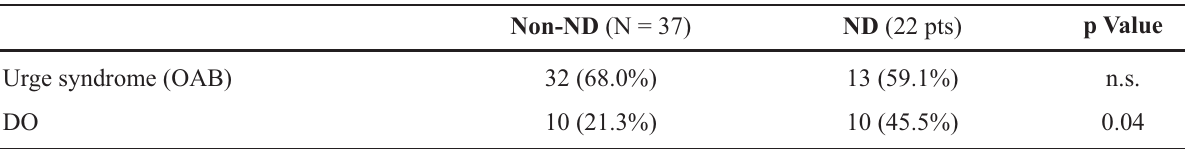
Table 1 – Incidence of urge syndrome (overactive bladder - OAB) and demonstrated urodynamic detrusor overactivity (DO) in the population with rhythmic rectal